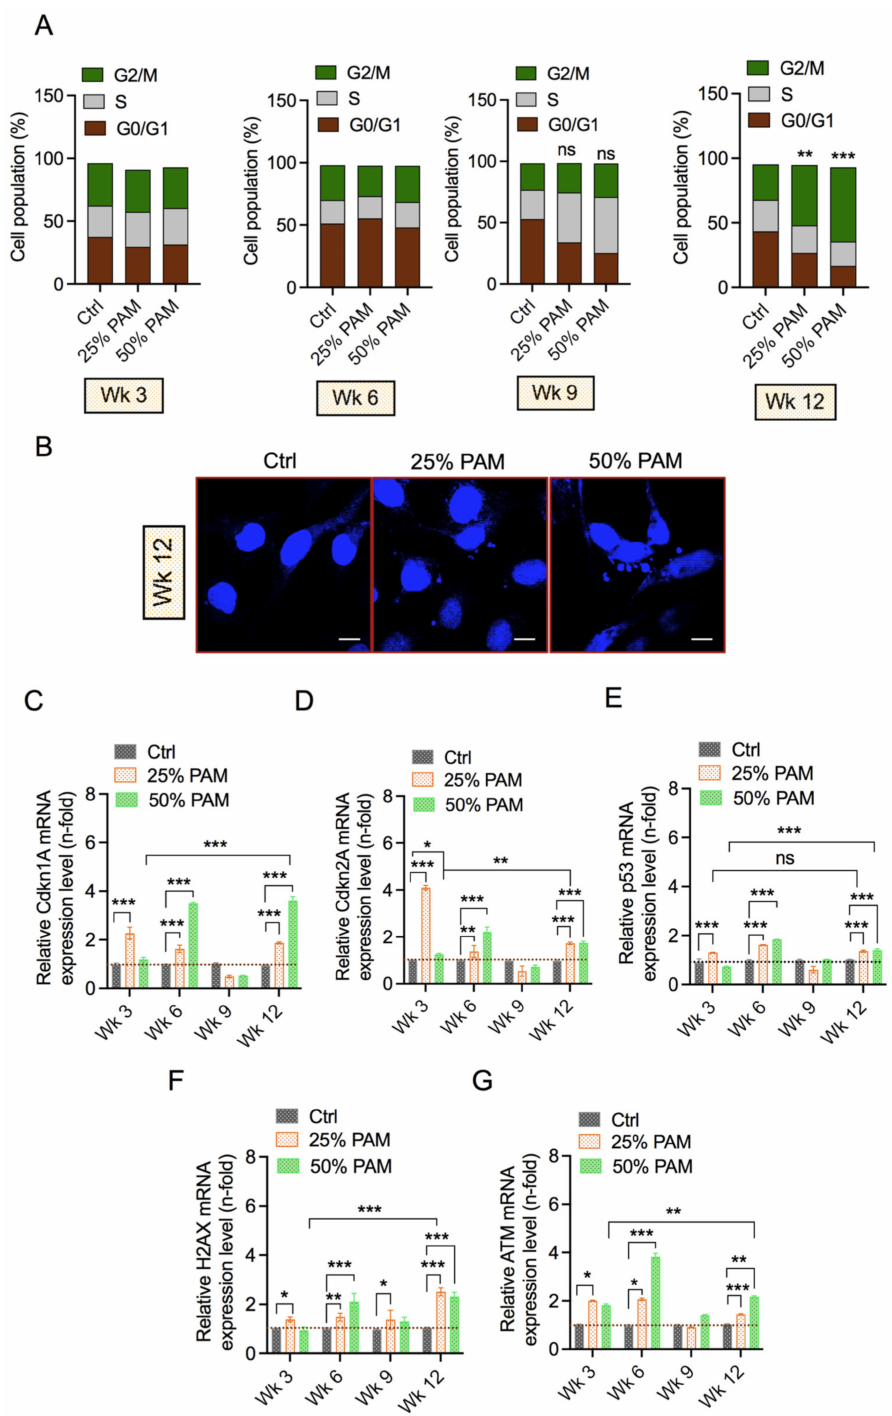
Figure 5. Evaluation of the DNA damage response and cell cycle phases after periodic PAM exposure in fibroblast cells. ( A ) Representative cell cycle phases in fibroblast cells after PAM exposure for weeks (Wk). Significance has been shown among various groups considering G2/M changes. Statis- tical significance was evaluated using Dunnett’s multiple comparison test with one-way ANOVA. ( B ) Representative confocal images of fibroblast cells stained with DAPI indicate changes in nuclear morphology. mRNA levels of cell cycle markers. ( C ) Cdkn1A, ( D ) Cdkn2A, and ( E ) p53. mRNA levels of DNA damage markers ( F ) H2AX and ( G ) ATM. Scale bar 100 µ M. Statistical significance was evaluated using Dunnett’s or Tukey’s multiple comparison test with two-way ANOVA and is indicated as * p < 0.05, ** p < 0.01, and *** p <